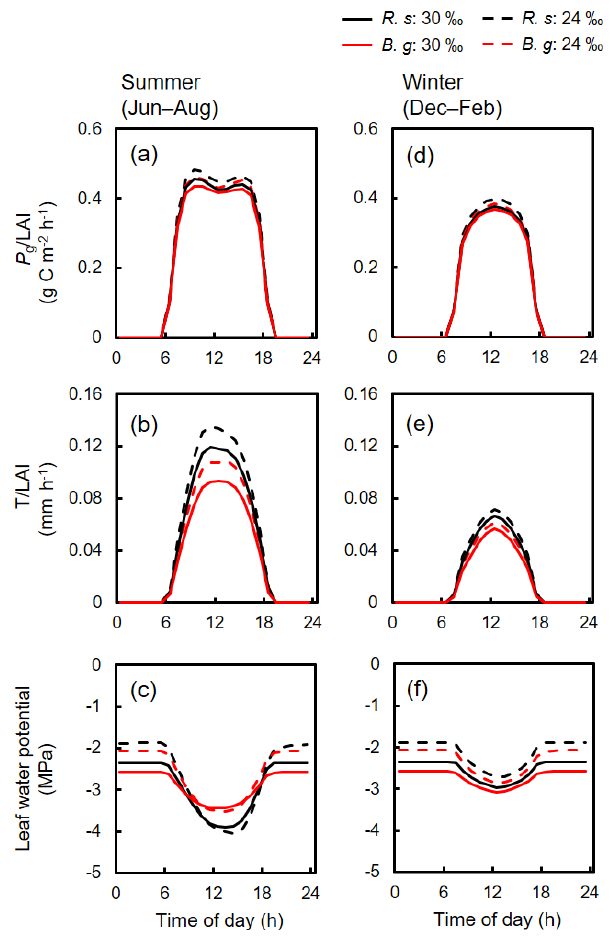
Figure 5. Simulated averaged diurnal variations in (a, d) photosyn- thesis and (b, e) transpiration of R. stylosa ( R. s ) and B. gymnor- rhiza ( B. g ) normalized with LAI of the respective species, and (c, f) leaf water potential of the two species for summer (June–August) and winter (December–February) under two soil salinity conditions (30‰ and 24‰). The variations under 30‰ soil salinity corre- spond to the results shown in Fig. 4. The variations under 24‰ soil salinity are from the results of a year that showed the same LAI (1.55). The diurnal variations in leaf water potential were derived based on the median value of